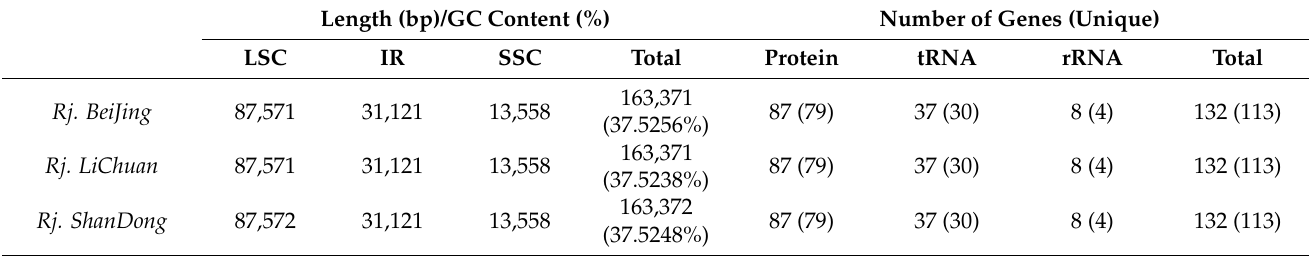
Table 1. Chloroplast genome features of the three R. japonica